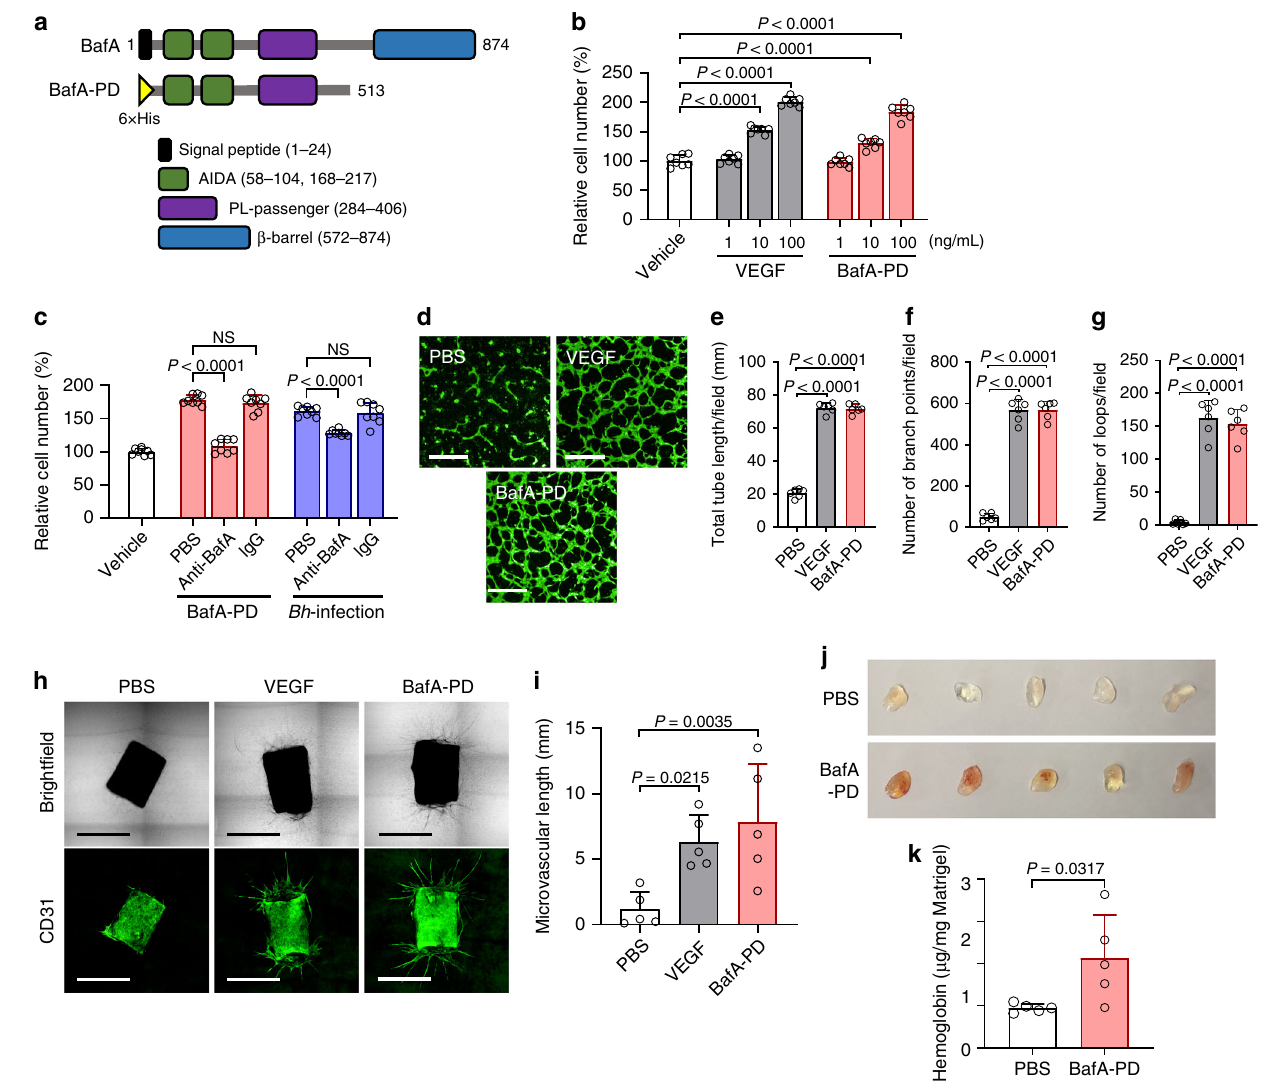
Fig. 3 BafA passenger domain possesses angiogenic activity. a Schematic representation of the full-length BafA autotransporter and the recombinant passenger domain (BafA-PD). His-tagged BafA-PD was constructed from the amino acid residues 25 – 513 of the full-length protein. AIDA, adhesin involved in diffuse adherence; PL-passenger, pertactin-like passenger domain; β -barrel, β -barrel domain. b Dose-dependent cell proliferation activity of BafA-PD ( n = 7 biological replicates). c Effect of anti-BafA antibody on cell proliferation. HUVECs were treated with BafA-PD (100 ng/mL) or Bh -infection (MOI